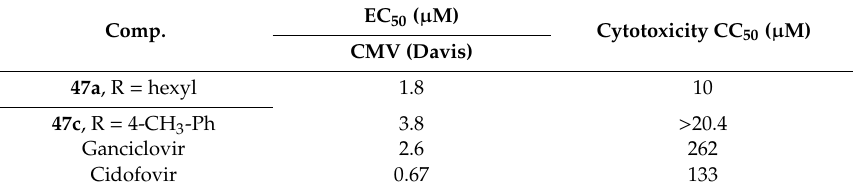
Table 20. The antiviral activities of C-5 substituted pyrimidine-4,5-didehydro- L -ASA derivatives. Comp.